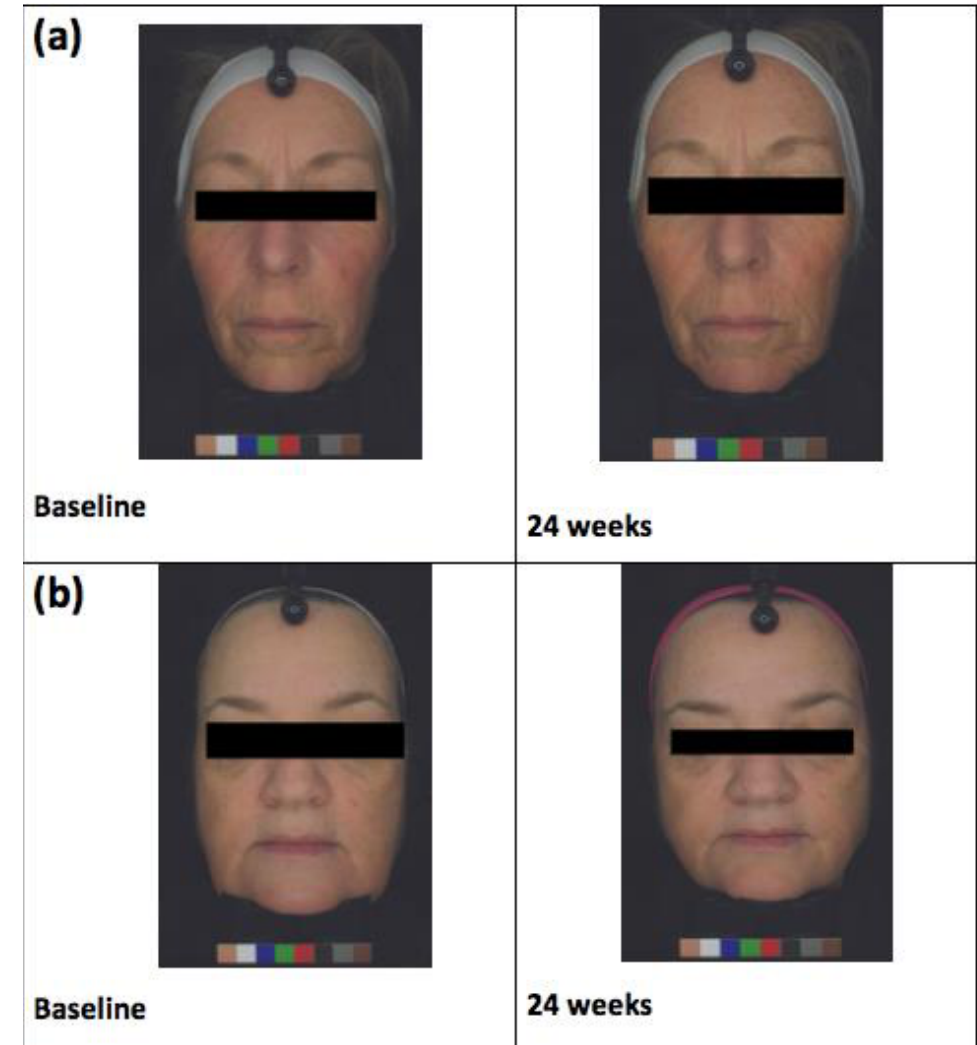
Figure 2. ( a ) Almond subject and ( b ) control subject facial images at baseline and at 24 weeks of receiving the almond or snack interventions, respectively.